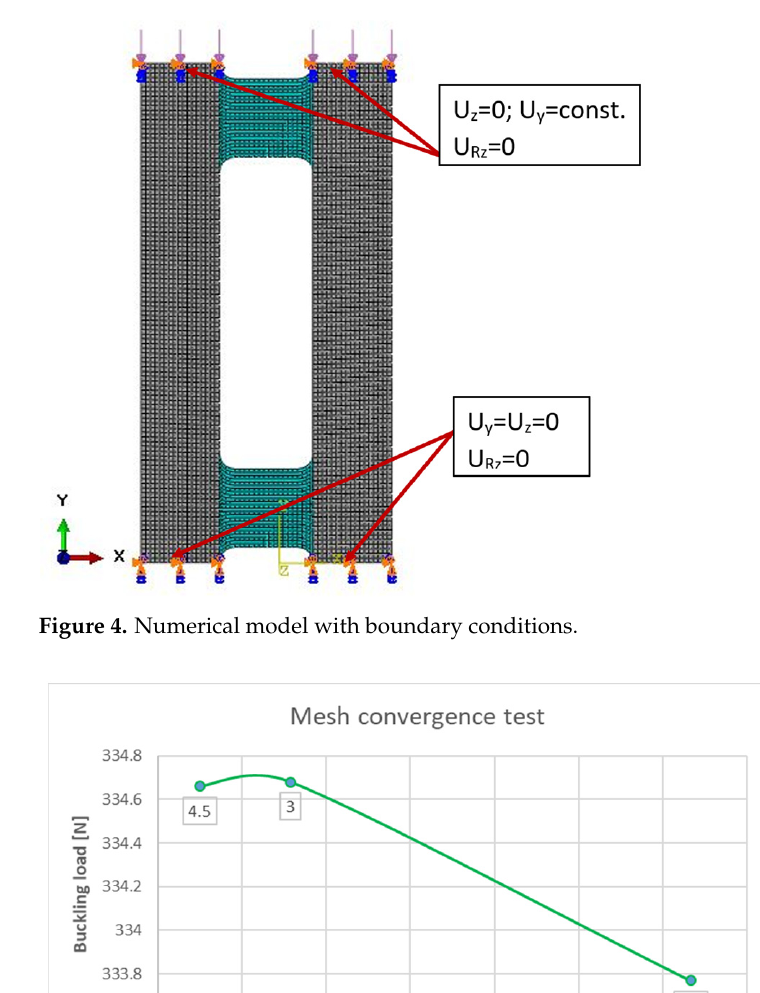
Figure 5. The convergence test.